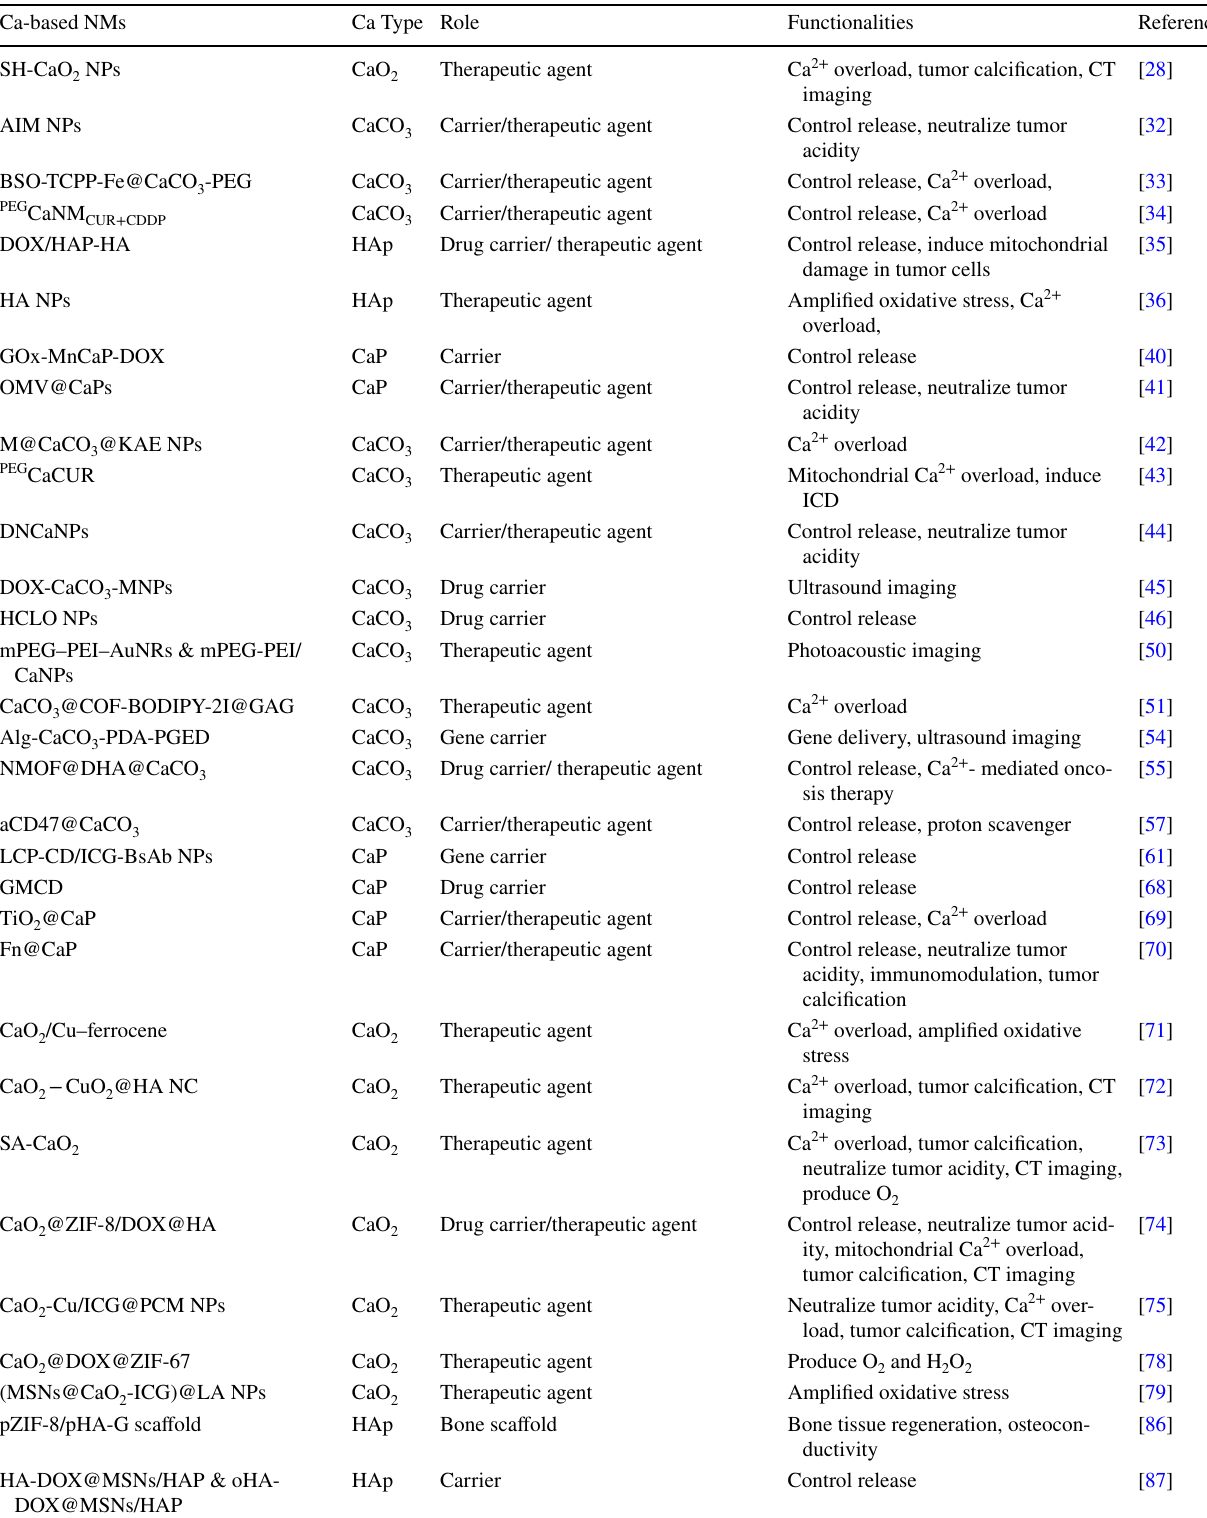
Table 1 A Summary of Major Application and Functionalities of Ca-NMs Ca-based